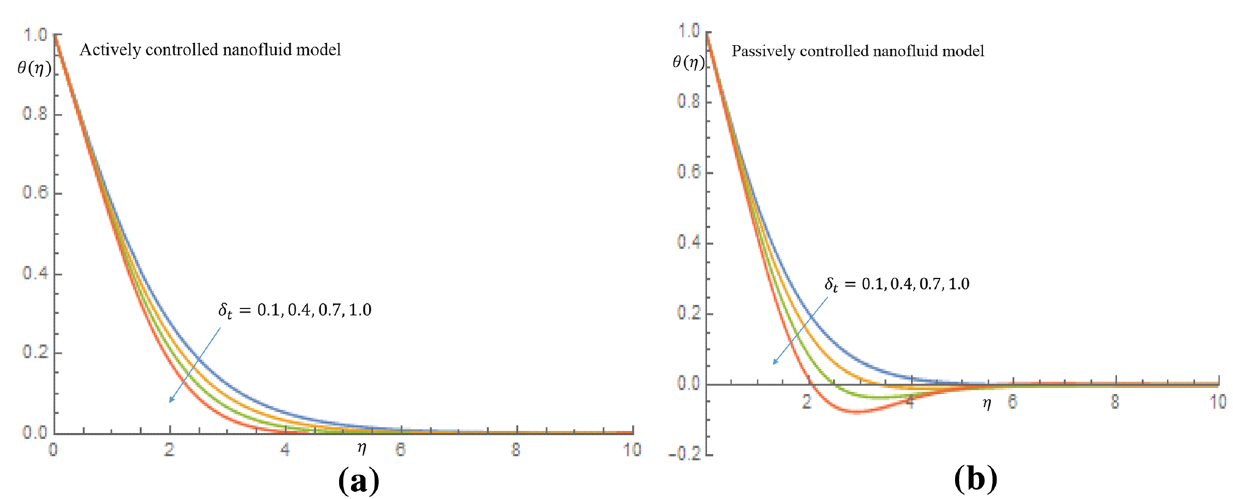
Figure 8. ( a ) Effect of δ t on temperature profile when K 1 = K 2 = 0 . ( b ) Effect of δ t on temperature profile when K 1 = K 2 = 0.